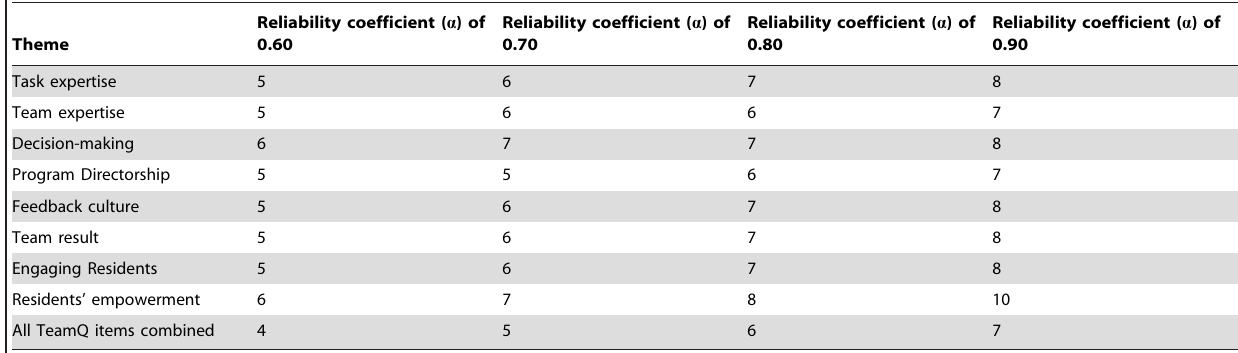
Table 6. Number of completed TeamQ evaluations needed to obtain reliable theme scores, based on generalizability analysis.